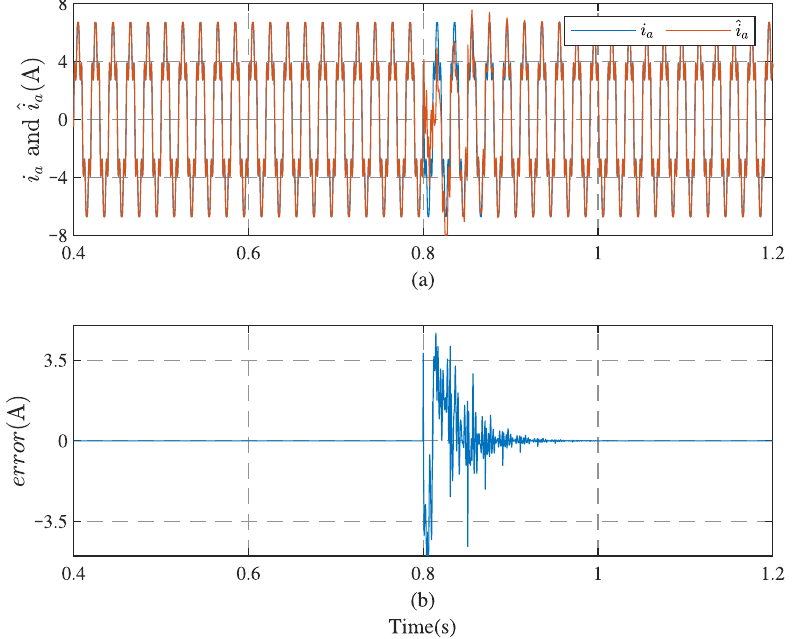
Figure 13. Simulation results with phase jump: ( a ) comparison between ˆ i a and i a . ( b ) Error